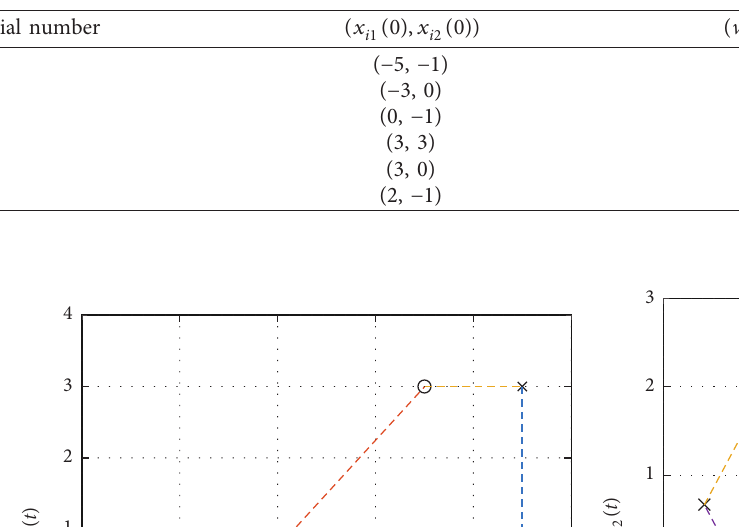
Figure 1: Communication network for static whole motion. Table 1: Initial values and formation vectors for static whole motion.